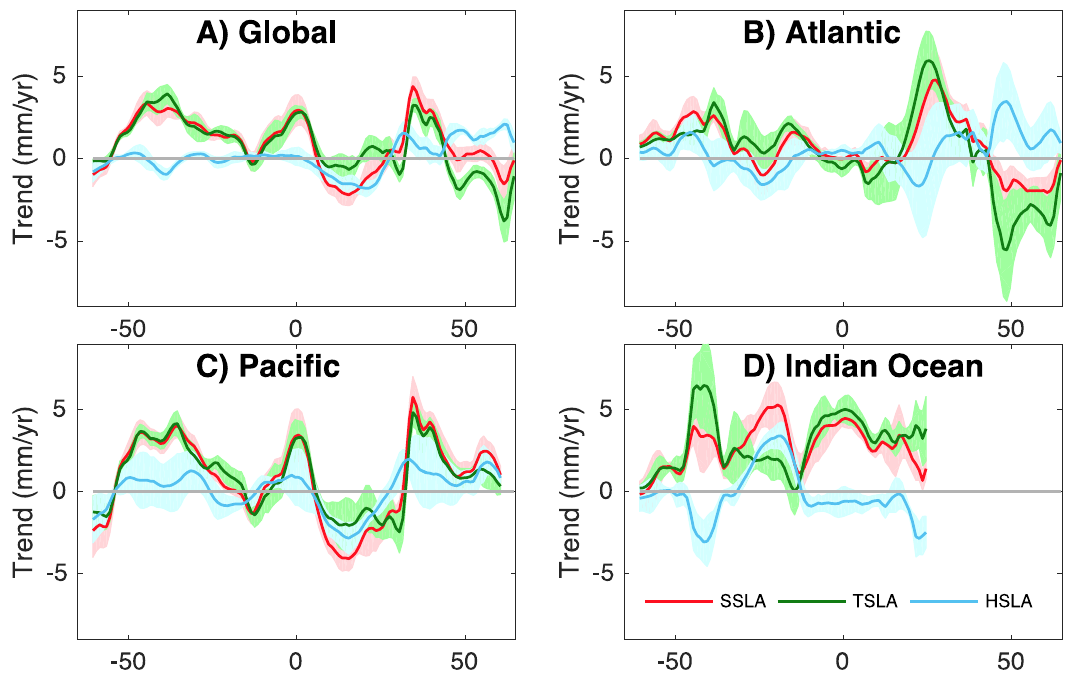
Figure 5. Zonal-averaged steric sea level trend in the global ocean ( A ); the Pacific Ocean ( B ); the Atlantic Ocean ( C ); and the Indian Ocean ( D ). Curves in different colors present the ensemble mean of SSLA (black), TSLA (red), and HSLA (blue), respectively. The standard deviation errors are attached in shadings.